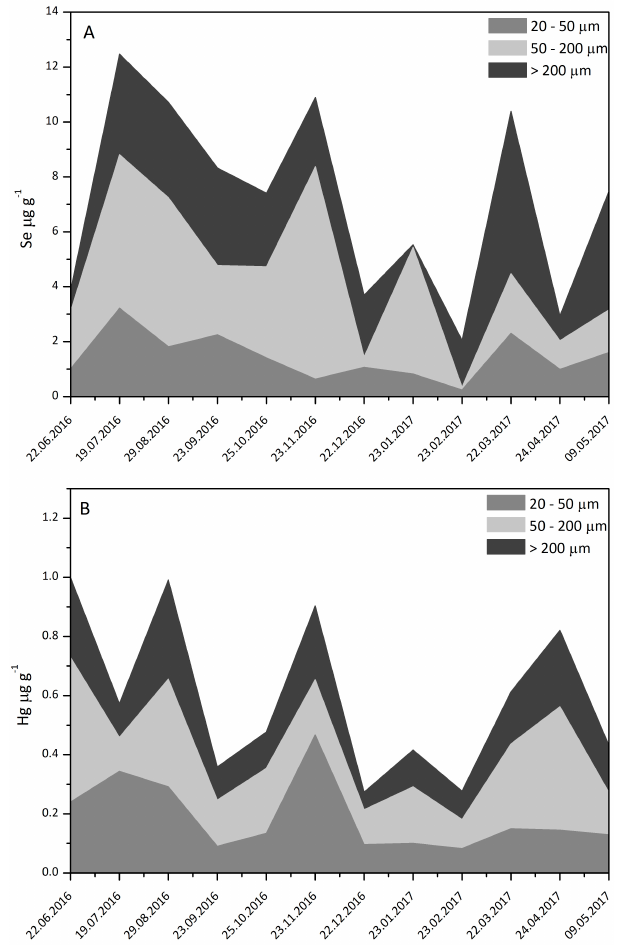
Figure 2. Temporal variation of Se ( A ) and Hg ( B ) concentrations in size-fractionated plankton in